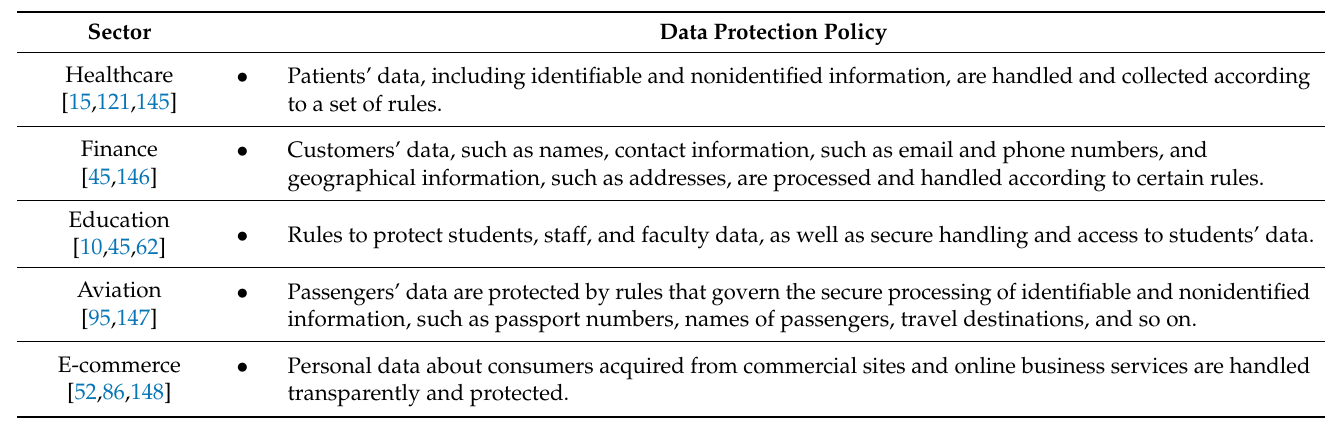
Table 11. Data-protection policy among different